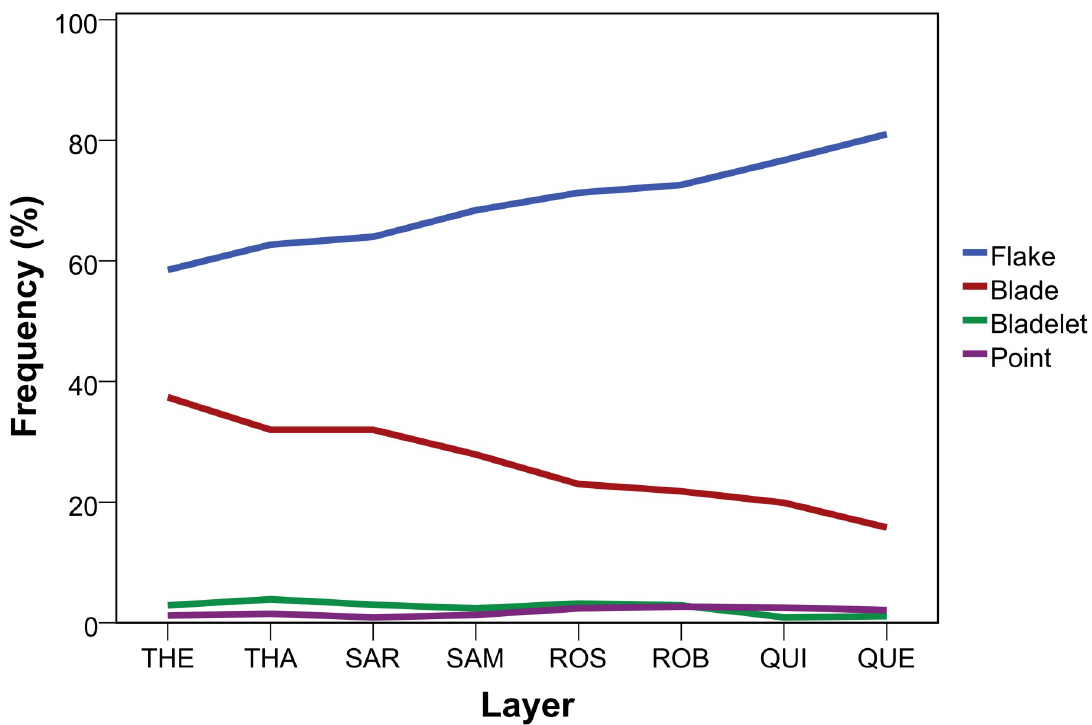
Fig 3. Diachronic variation of blank types produced throughout the HP at Sibudu. THE = oldest layer; QUE = youngest layer.